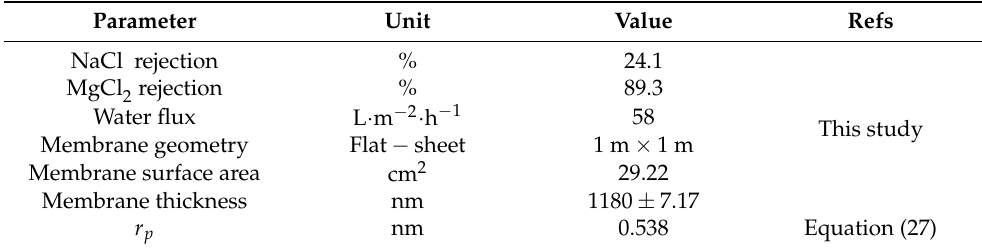
Table 2. Membrane parameters used in this work.